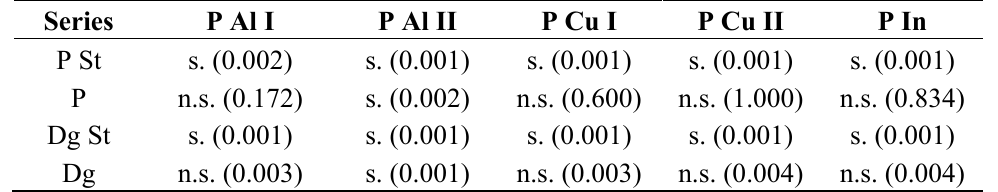
Table 5. Statistical tests of the shear bond strengths of all implanted and non-implanted test series; p -values (s = significant, ns = not significant).